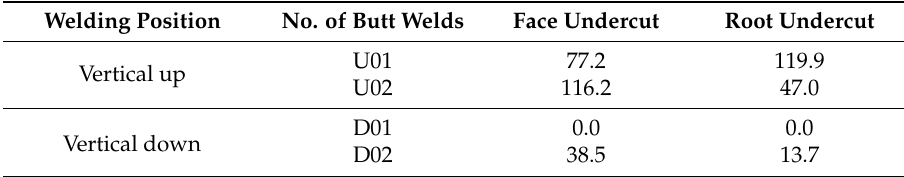
Table 3. Undercuts of welds produced with different welding conditions (unit: µm). Welding Position No. of Butt Welds Face Undercut Root Undercut U01 77.2 119.9 Vertical up U02 116.2 47.0 D01 0.0 0.0 Vertical down D02 38.5 13.7